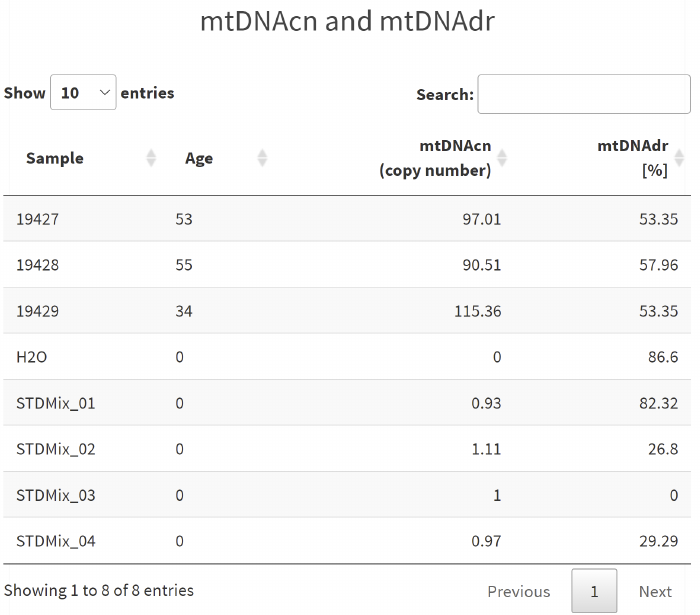
Figure 4. Result table showing computed mtDNA CN and mtDNA DR values from example